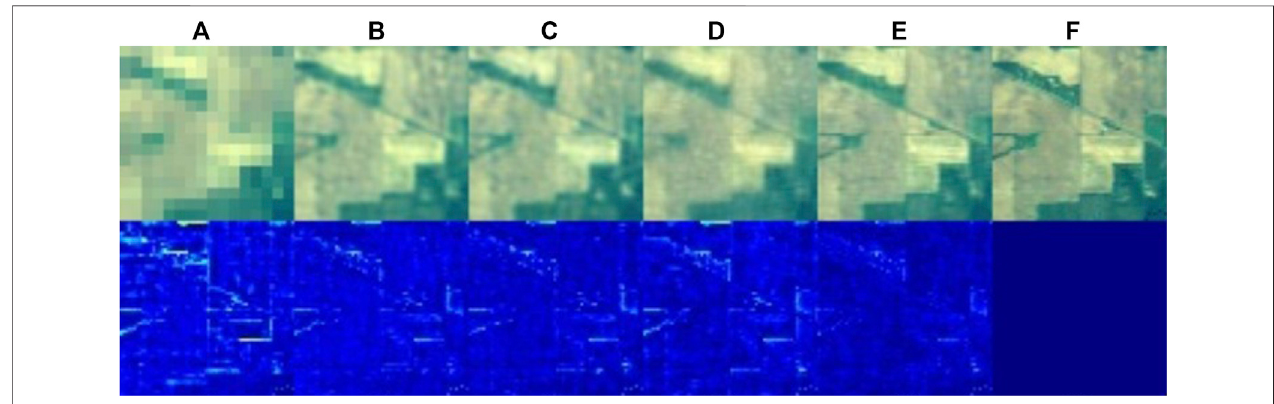
FIGURE 4 | Qualitative comparison on Indian Pines dataset in case of 4× spatial downsampling. For visualization purposes, three spectral bands (28-14-3) are selectedfromtheoutputdataanddifferenceimagesarecalculatedbasedonthatpreselectedthreebands.The fi rstrowshows (A) inputLRHSI, (B) SSFCNNoutput,